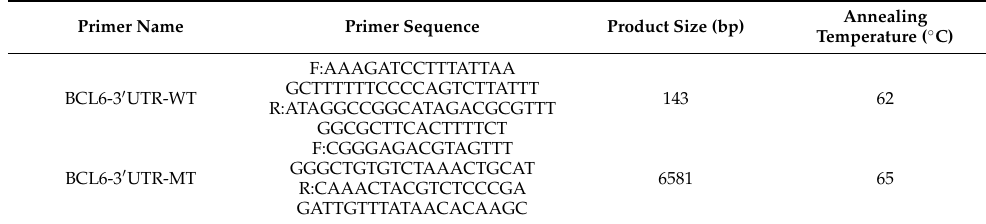
Table 4. Homologous recombinant primers for the BCL6